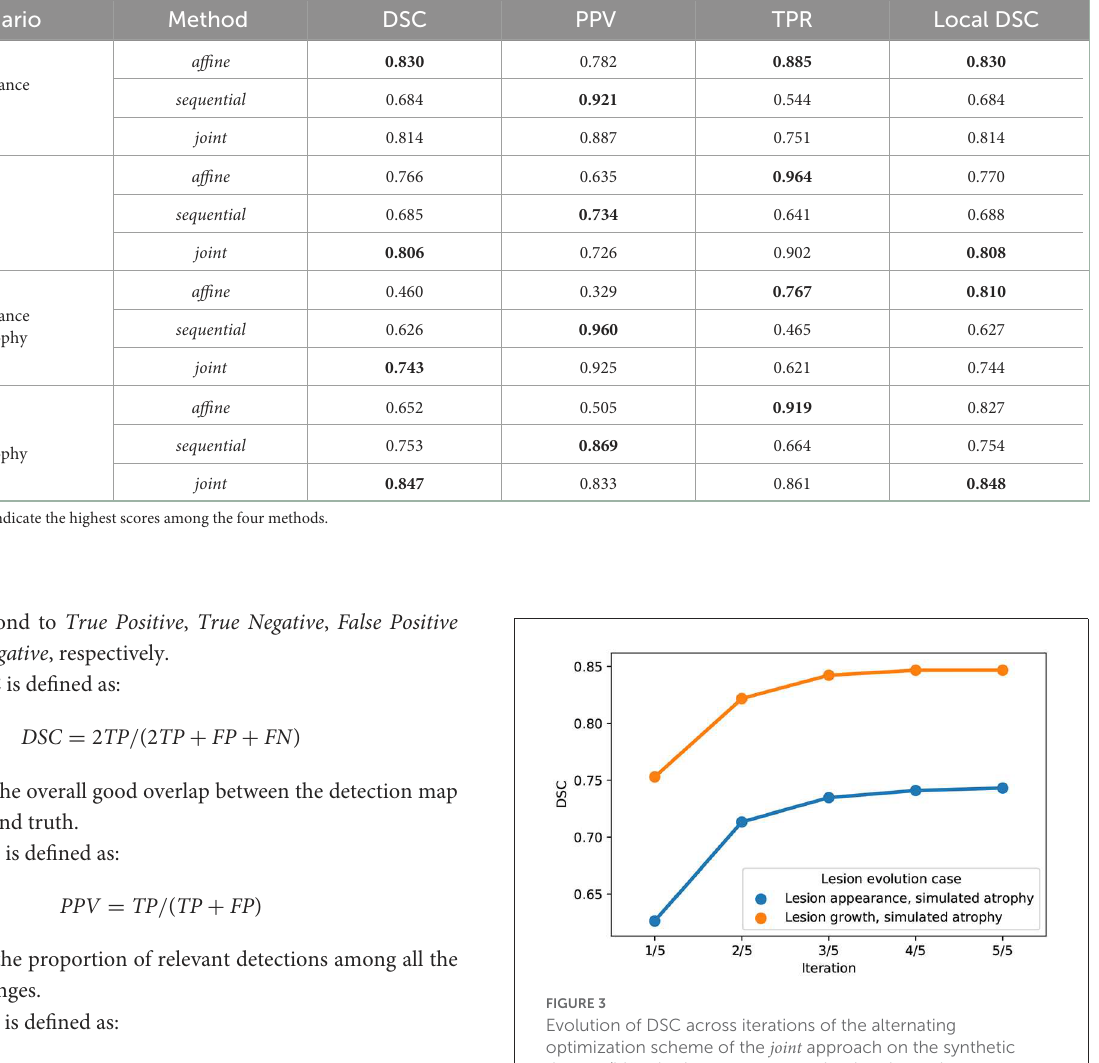
TABLE 2 Results computed on the synthetic dataset.